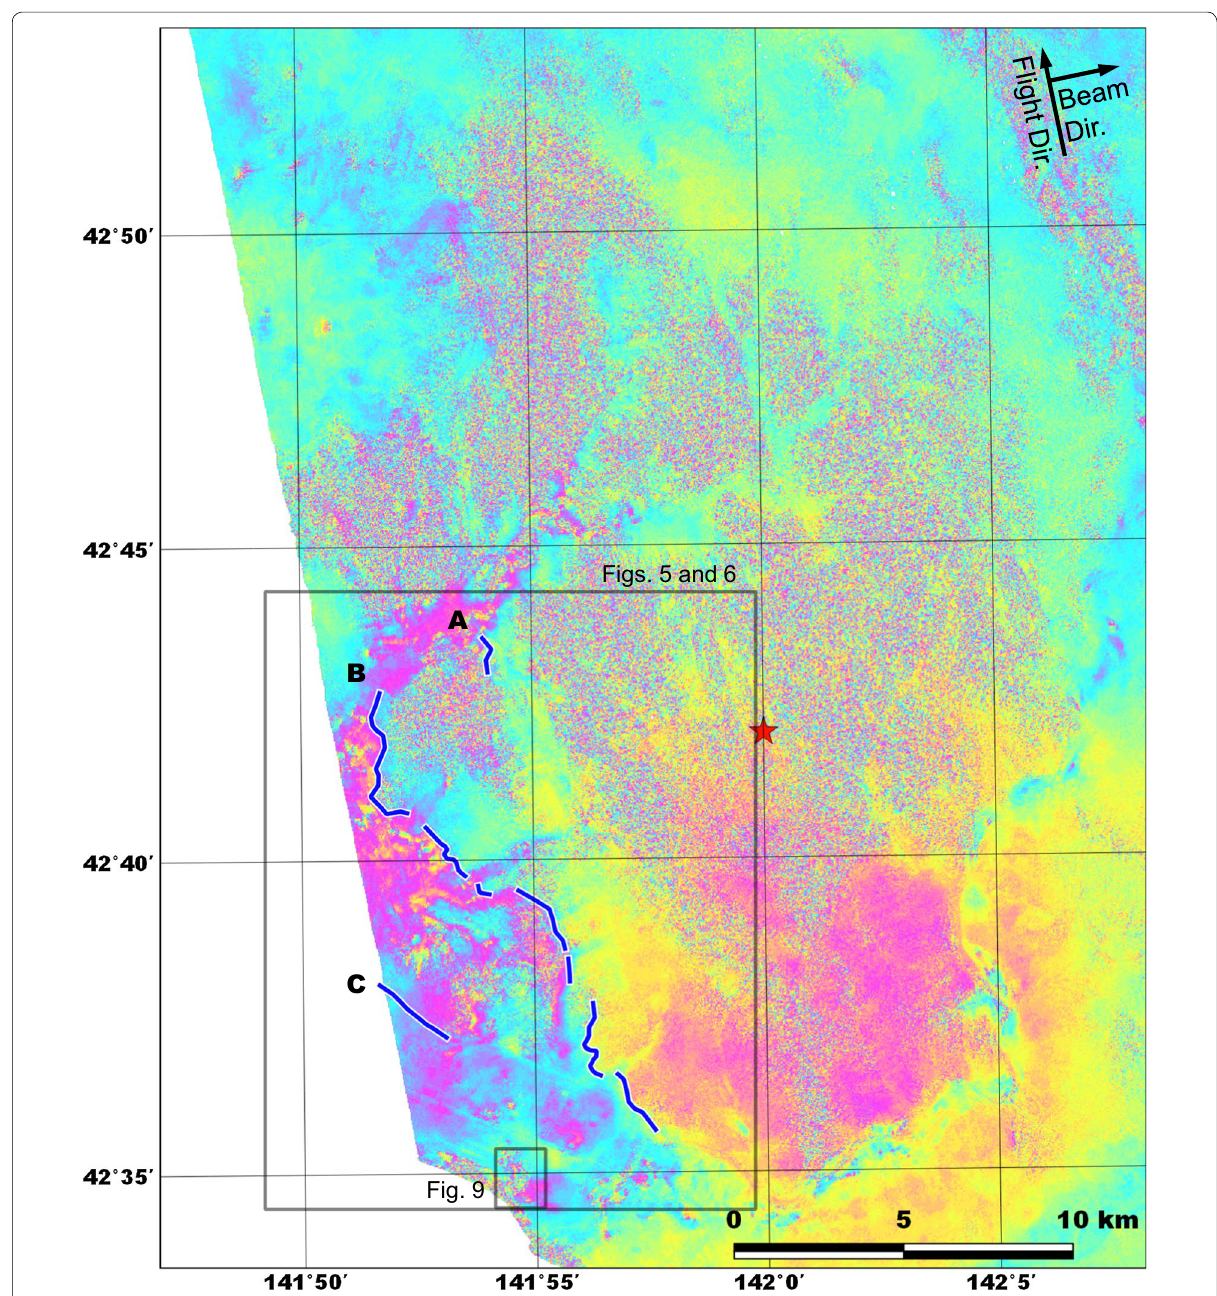
Fig. 4 ALOS-2 SAR interferogram of image pair 5 (Table 1) showing the linear surface displacements identified in this study. The red star shows the epicenter of the 2018 Hokkaido Eastern Iburi Earthquake (Earthquake Research Committee 2018). Rectangles show the area of other figures. Blue lines show the identified linear surface displacements (interferograms without these features are given in Additional file 1: Fig.